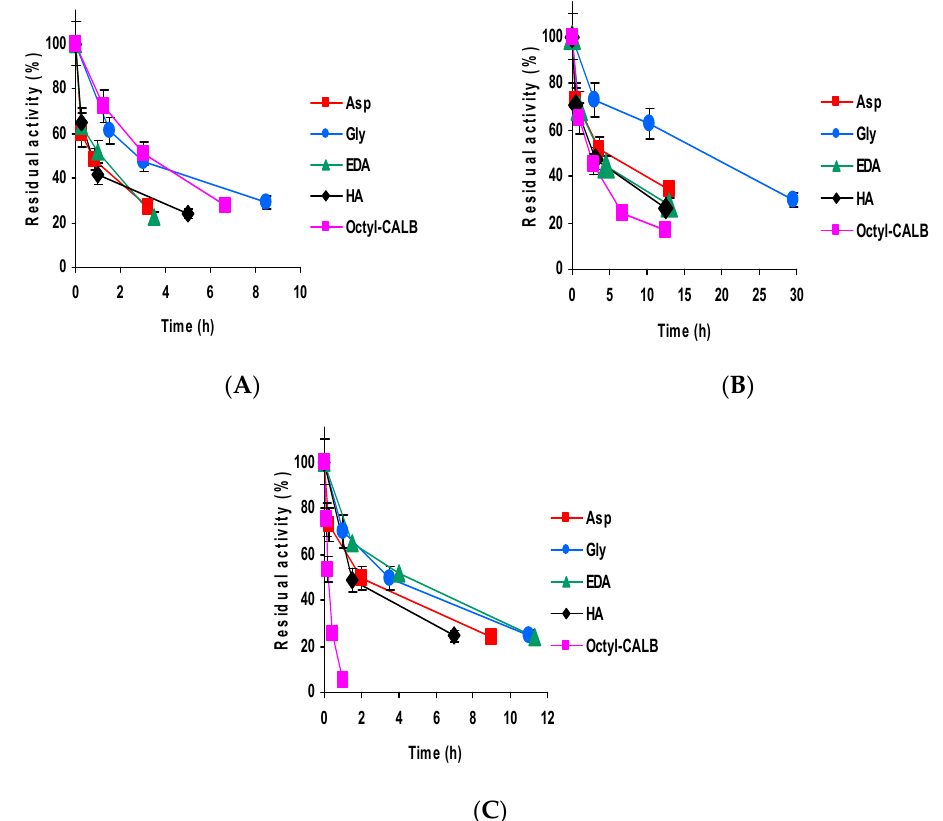
Figure 2. Inactivation courses of CALB biocatalysts. Inactivation conditions: ( A ) 50 mM of sodium acetate at pH 5.0 and 80 ◦ C; ( B ) 50 mM of Tris HCL 50 mM at pH 7.0 and 75 ◦ C; ( C ) 50 mM of sodium carbonate at pH 9.0 and 60 ◦ C. Experiments were carried out as described in Methods.